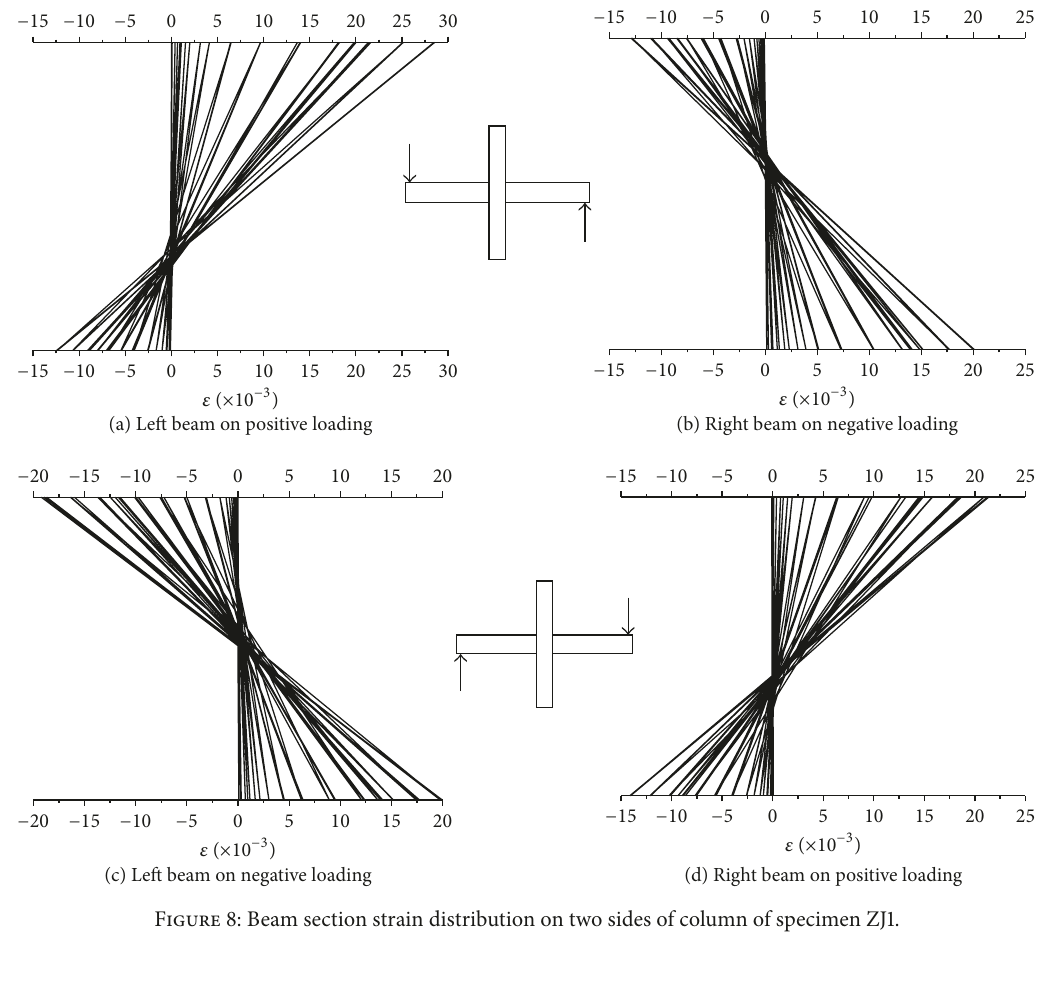
Figure 8: Beam section strain distribution on two sides of column of specimen ZJ1.